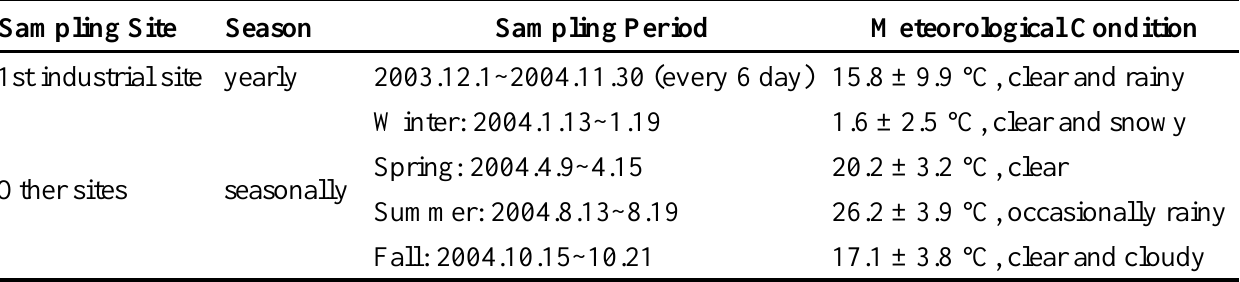
Table 1. Sampling periods and meteorological conditions for each site.